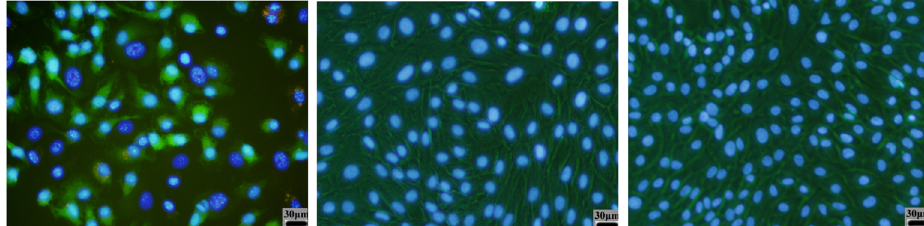
Figure 5. Nuclei were counterstained with Hoechst 33258 and observed under a fluorescence microscope. All cells were cultured for 48 h in different culture environments. Cells in the AGE-BSA group ( left panel ) showed bright blue dots in the nuclei, which represented nuclear fragmentation in the apoptotic cells. Cells in the BSA group ( middle panel ) and control group ( right panel ) were uniformly blue in viable cells. Magnification, 400 6